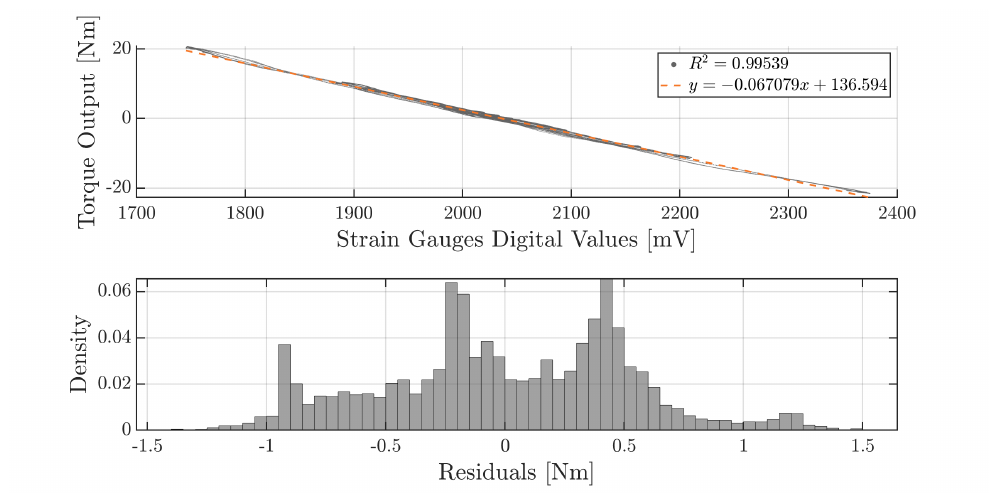
Figure 6. Calibration of the strain gauges used to estimate the output torque generated by the SMARCOS. A linear regression (in orange) was applied to the gathered data (in grey). A coefficient of determination ( R 2 ) of 0.995 suggests a good match between the model and the data. For sake of validation, the distribution of the residuals was also analysed. The symmetry around the origin and the absence of extreme value points confirm the validity of the